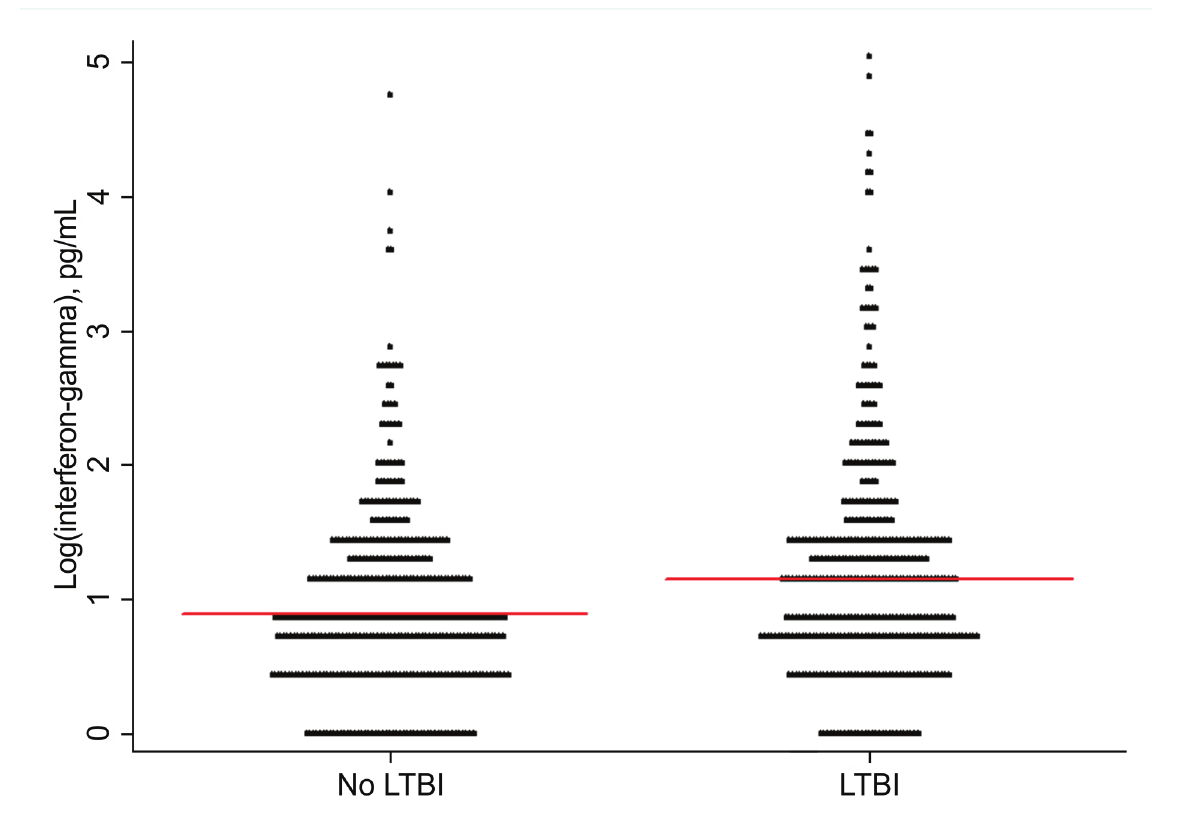
Figure 1. Interferon-gamma concentrations by latent tuberculosis infection (LTBI) status. The median is indicated with the red